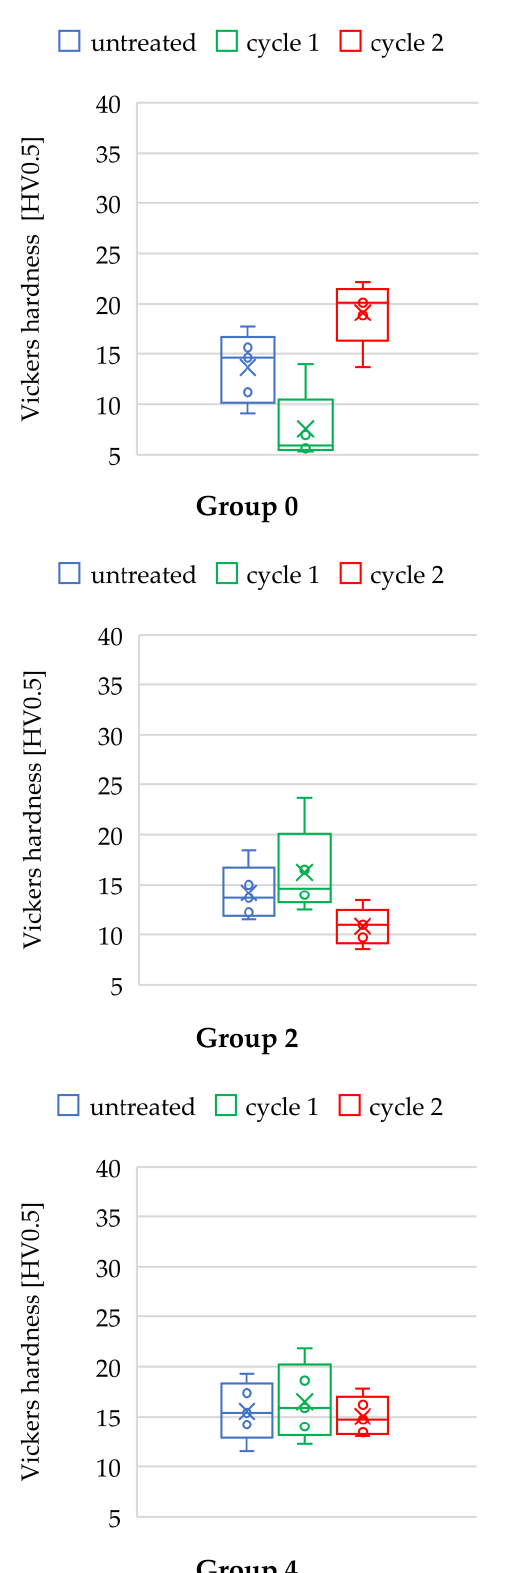
Figure 3. Boxplots: Vickers hardness of the different groups and subgroups. The x represents the mean, the circles represent data points not covered by the boxplots.